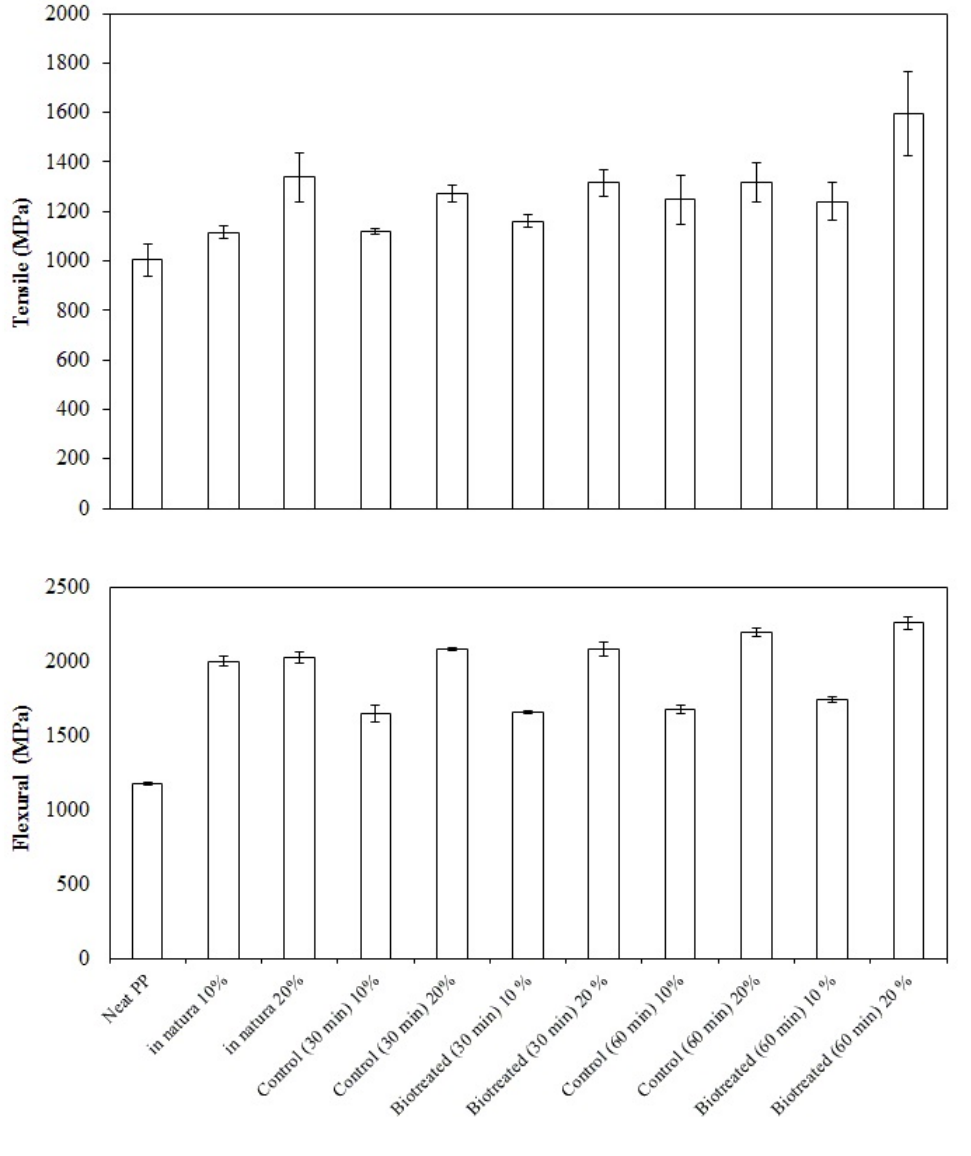
Fig 2. Tensile and flexural moduli of polypropylene composites reinforced with in natura bagasse, control and biotreated bagasse pulps and neat PP. Percentage of reinforcement (%) is described in